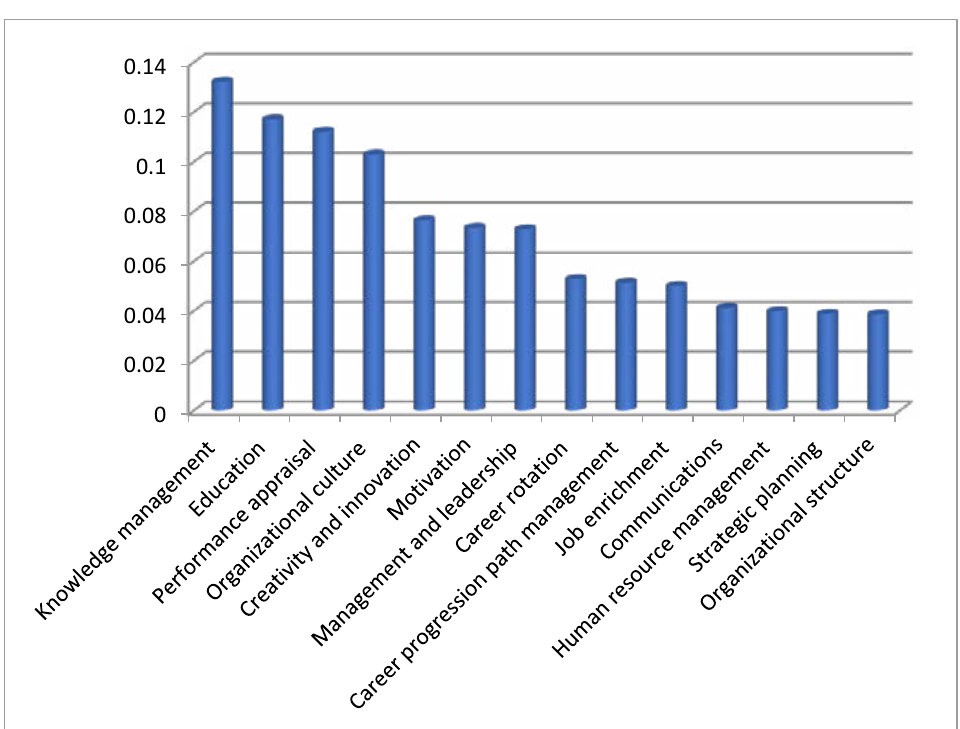
Fig. 7. The final priority chart of HRD criteria for SOE